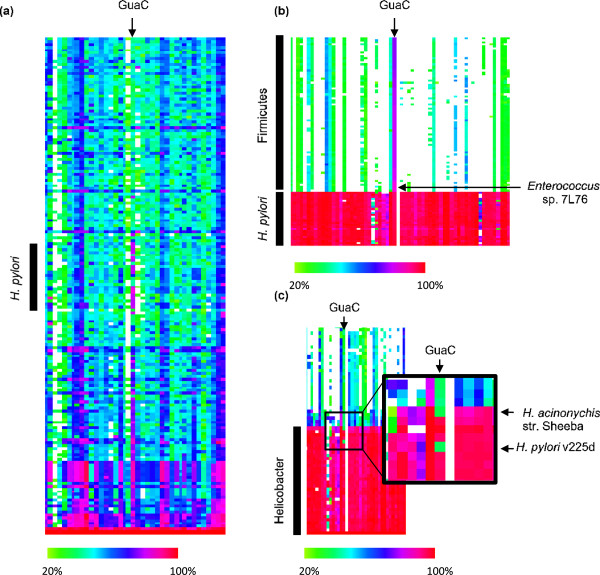
CodaChrome heat maps reveal unexpected sequence relationships. a) A region of the CodaChrome heat map in which B. subtilus was loaded as the seed organism, the rows were sorted according to whole proteome identity, and alignments with pairwise percent identities below 20% were filtered out. b) A region of the CodaChrome heat map in which H. pylori P12 was loaded as the seed organism, the rows were sorted according by identity to GuaC of H. pylori P12, and alignments with pairwise percent identities below 20% were filtered out. c) Enlargement of the region around GuaC of a CodaChrome heat map with H. pylori P12 loaded as the seed proteome and rows sorted by whole proteome percent identity.